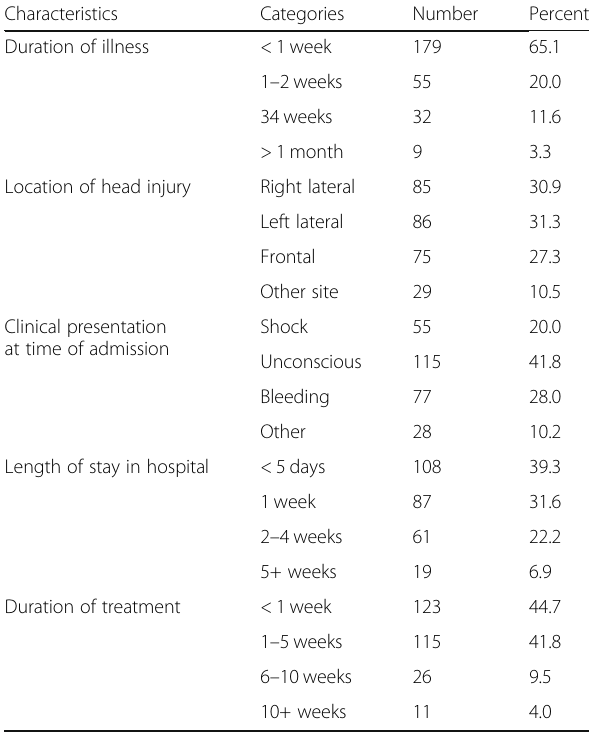
Table 2 Characteristics of injures of study participants attending emergency outpatient department of Hawassa University compressive specialized hospital, Hawassa, Southern Ethiopia ( n = 289)